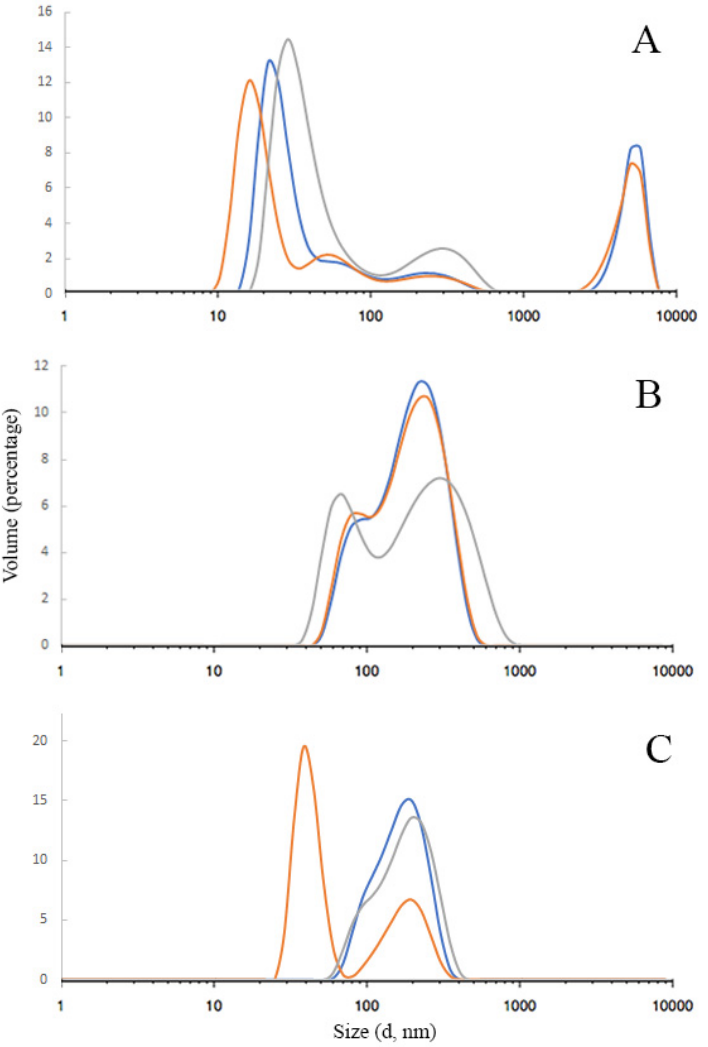
Figure 3. Silver nanoparticles size distribution measured by dynamic light scattering; ( A )—sample #1 with collagen hydrolysate); ( B )—sample #2 (with PVP); ( C )—sample #3 (mixture). The different-colored curves represent the results obtained from three independent measurements.